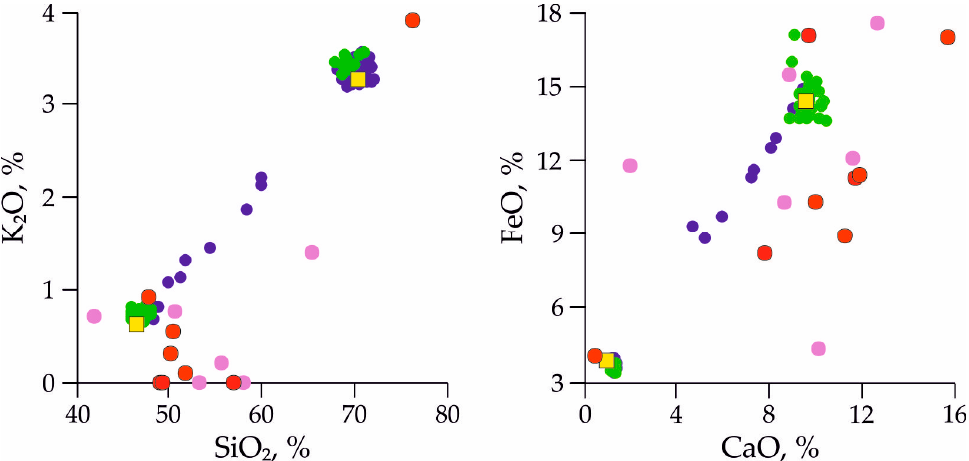
Figure 10. Bi-plots of major oxides in the ash material from the core AMK-340 sample of 323–325 cm in comparison to the published data. Black-outlined red circles are the geochemical measurements of the solid shards in the sample of 323–325 cm. Pink circles are the geochemical measurements of the pisolites in the sample of 323–325 cm. Blue circles are data of the Vedde Ash from the lake Kråkenes in western Norway, green circles are data from the lake Loch Ashik in Scotland, and black-outlined yellow squares are data from the Greenland NGRIP ice core [9].